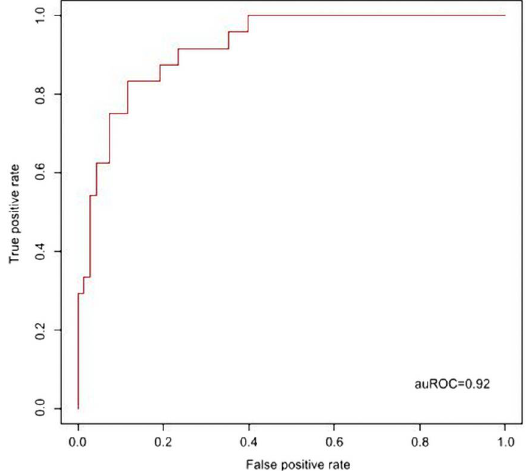
Figure 2. The performance of KD prediction model developed with 5 selected candidate proteins. Using the values of five selected proteins, we developed a KD prediction model with auROC = 0.92 (95% CI: 0.84, 0.98).